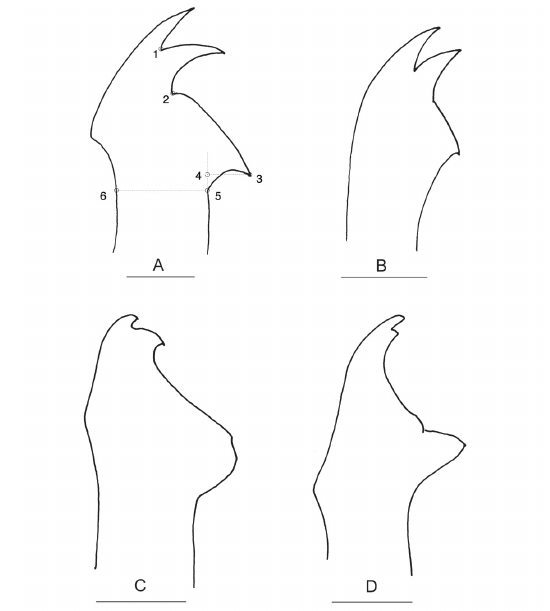
F IG . 2. – A: Large chaeta of Haplosyllis crassicirrata n. sp. Measures used to compare the chaetal profile (for largest chaeta after Martín et al . 2003); MJ (distance between 1-2), BMF (distance between 2-4), SW (6-5), LMF (distance between 3-4), US (dis- tance between 2-3), LS (distance between 3-5). B: Small chaeta of Haplosyllis crassicirrata n. sp. C: Chaeta of Haplosyllis basticola (after Sardá et al ., 2002); D: Chaeta of Haplosyllis anthogorgicola (after Utinomi, 1956). Scale A, B: 2 μ m; D: 2.5 μ m ; E : 12.5 μ